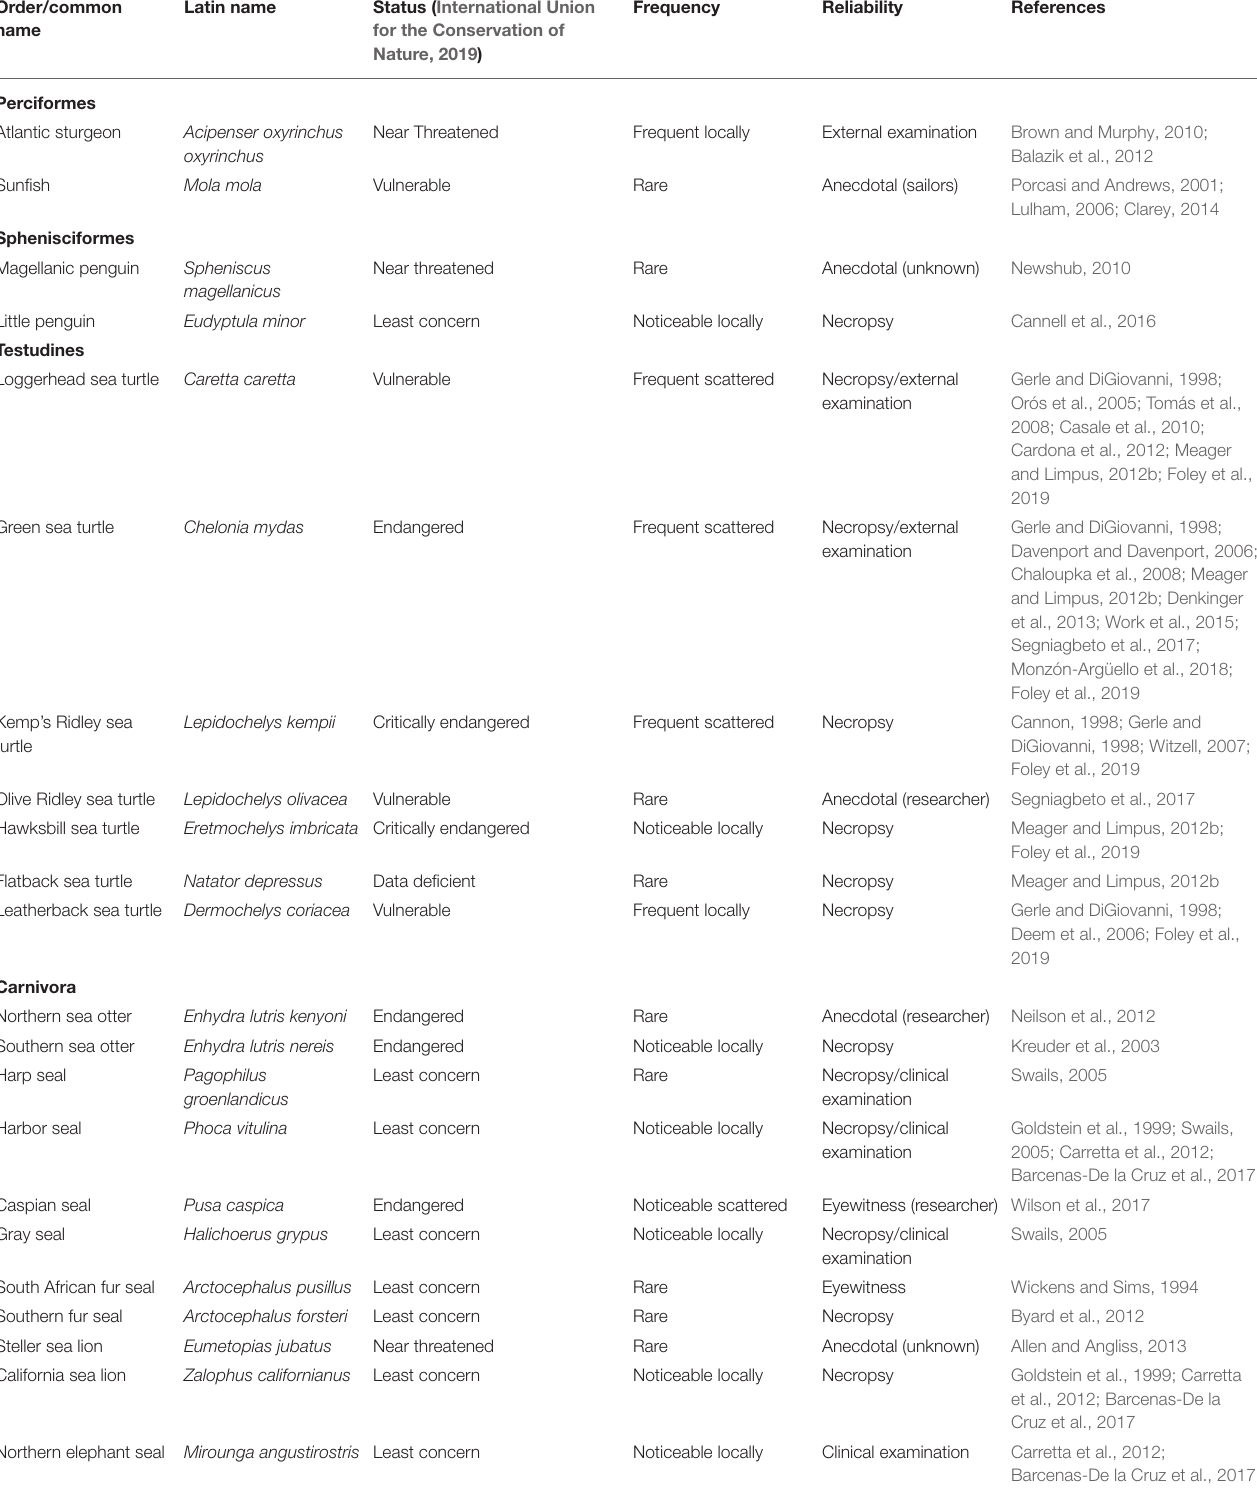
TABLE 1 | Table of species identified as struck by